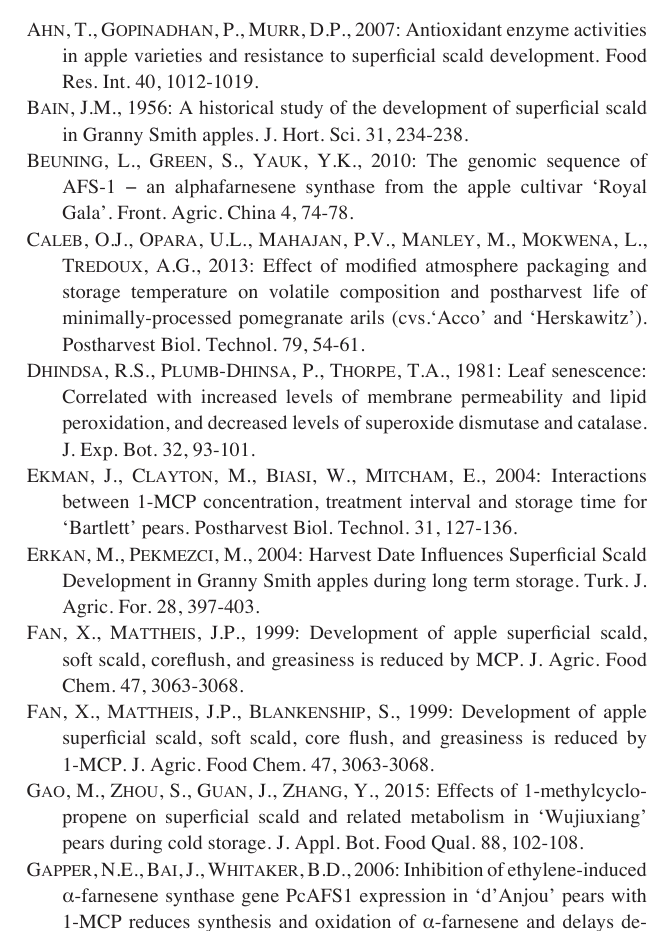
Tab. 2: Confusion matrix of ‘Granny Smith’ apples with different levels of superficial scald severity Superficial